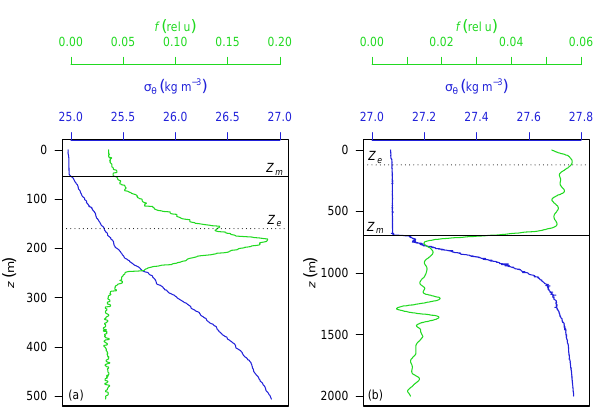
Fig. 1. Typical potential density anomaly profile σ θ (kgm − 3 ) (blue line) and fluorescence profile f (relative units) (green line) for (a) stratified waters and (b) mixed waters. The mixed layer depth Z m (plain line) and the euphotic depth Z e (dashed line) are